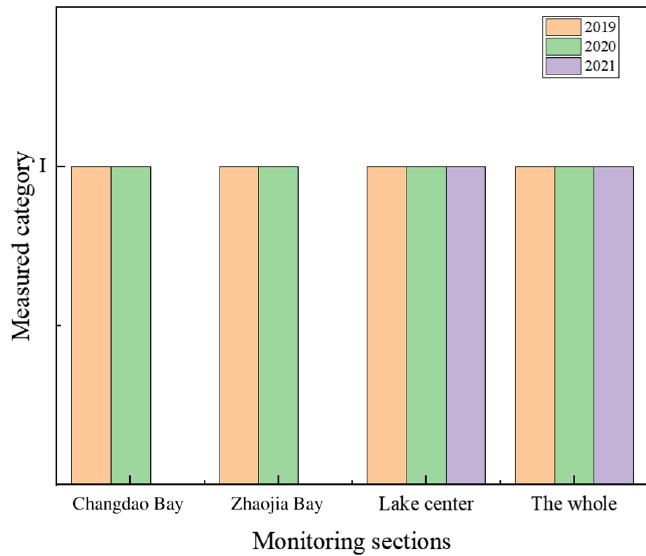
Figure 2. Water quality statistics of Lugu Lake in 2019, 2020 and 2021.